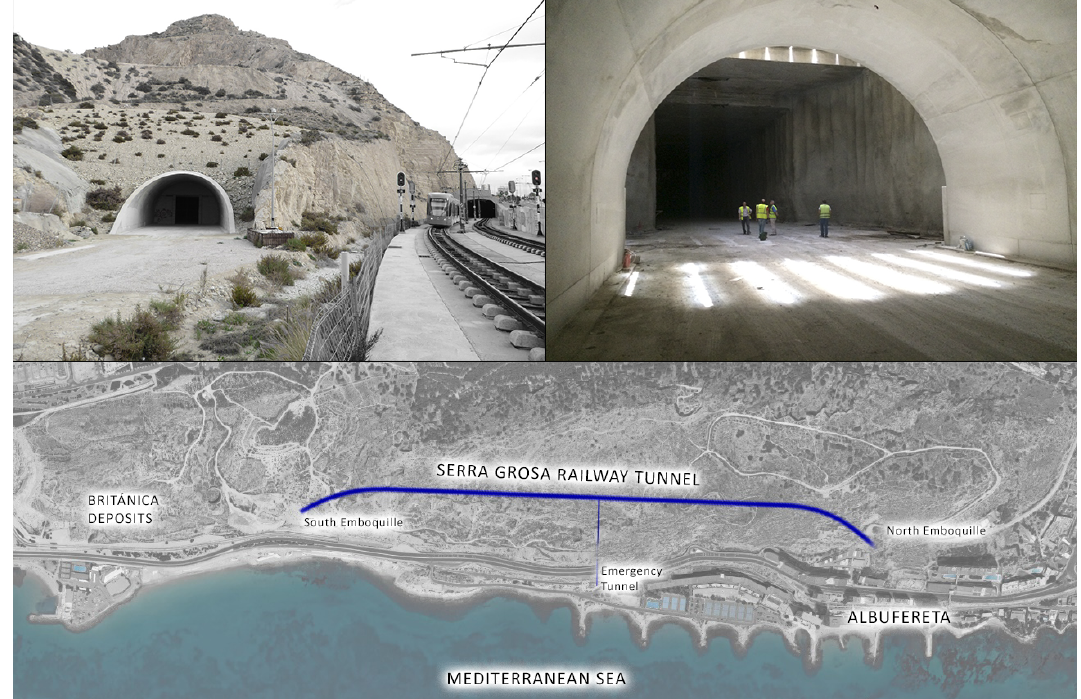
Figure 8. Google Maps image of the Serra Grossa with the location of the two infrastructures studied. (Own elaboration).